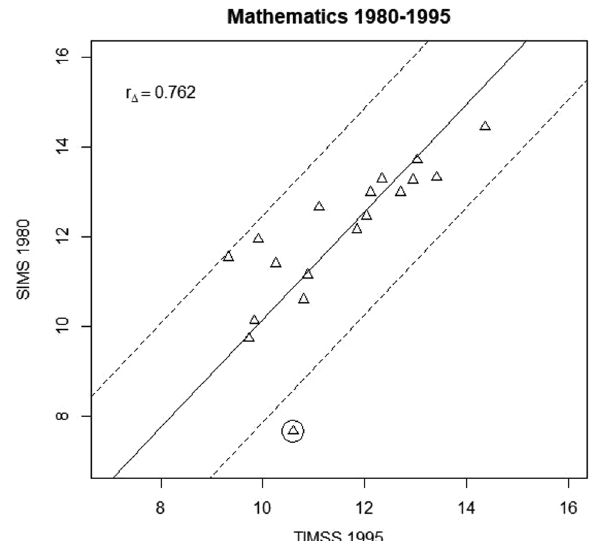
Fig. 5 Delta plot of the bridge between SIMS and TIMSS